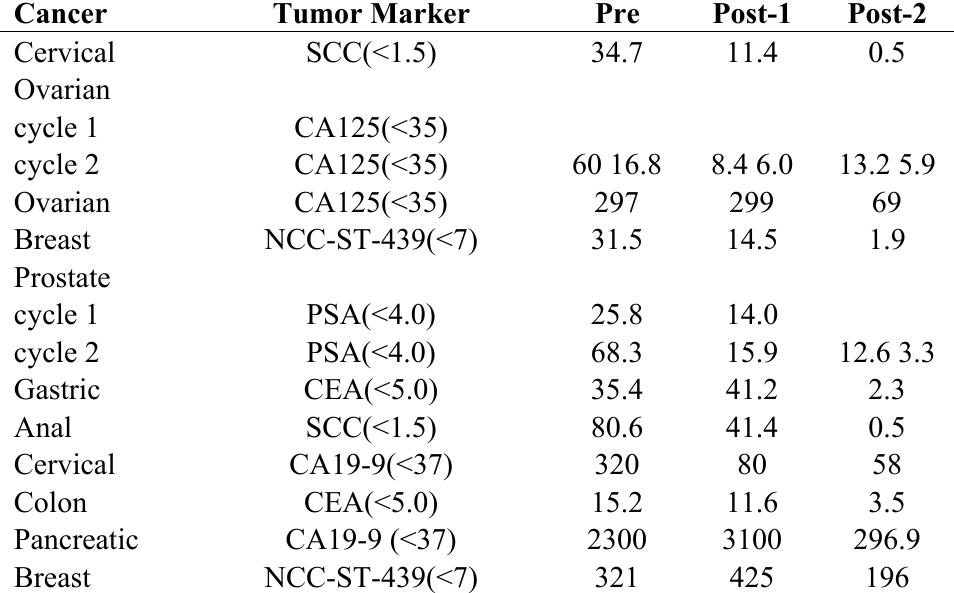
Sample collection: Pre, at enrollment; Post-1, at evaluation shortly after 2nd iDC injection and AT infusion; Post-2, at last